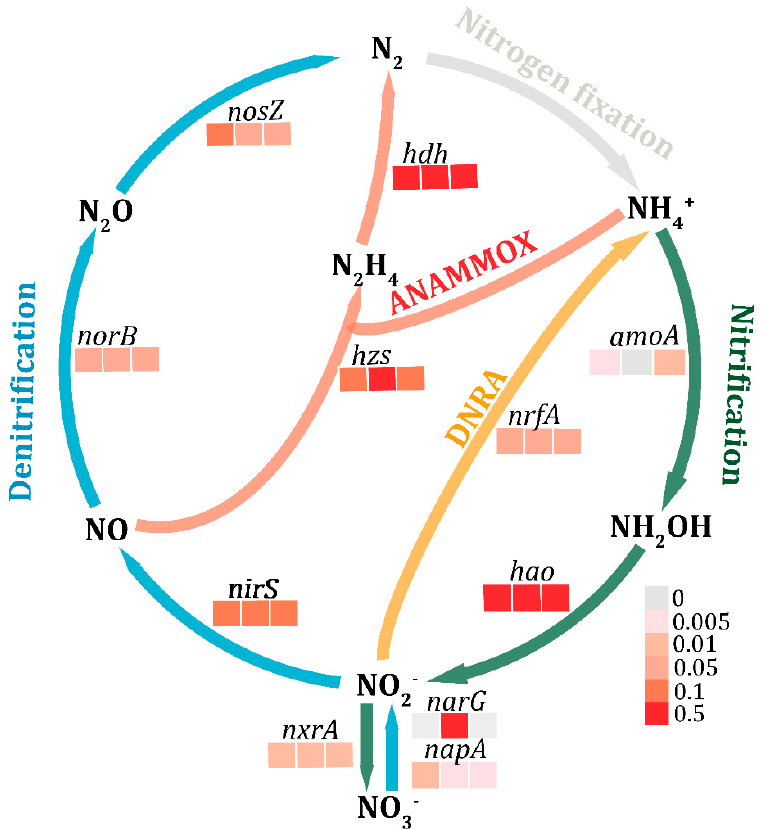
Figure 5. Relative abundance of microbiota and functional genes in the anammox bioreactors. amoA , bacterial ammonia monooxygenase subunit A; hzo , hydroxylamine oxidoreductase; narG , cytoplasmic nitrate reductase alpha subunit; napA , periplasmic nitrate reductase precursor; nrfA , ammonia-forming dissimilatory nitrite reductase; nxrA , nitrite oxidoreductase alpha subunit; nirS , cytochrome cd 1 nitrite reductase; norB , nitric oxide reductase subunit B; nosZ , nitrous oxide reductase. The abundance of the enzymes in each sample is shown in the color bars, and the location in the bar from left to right shows HS0, HS1 and HS10.